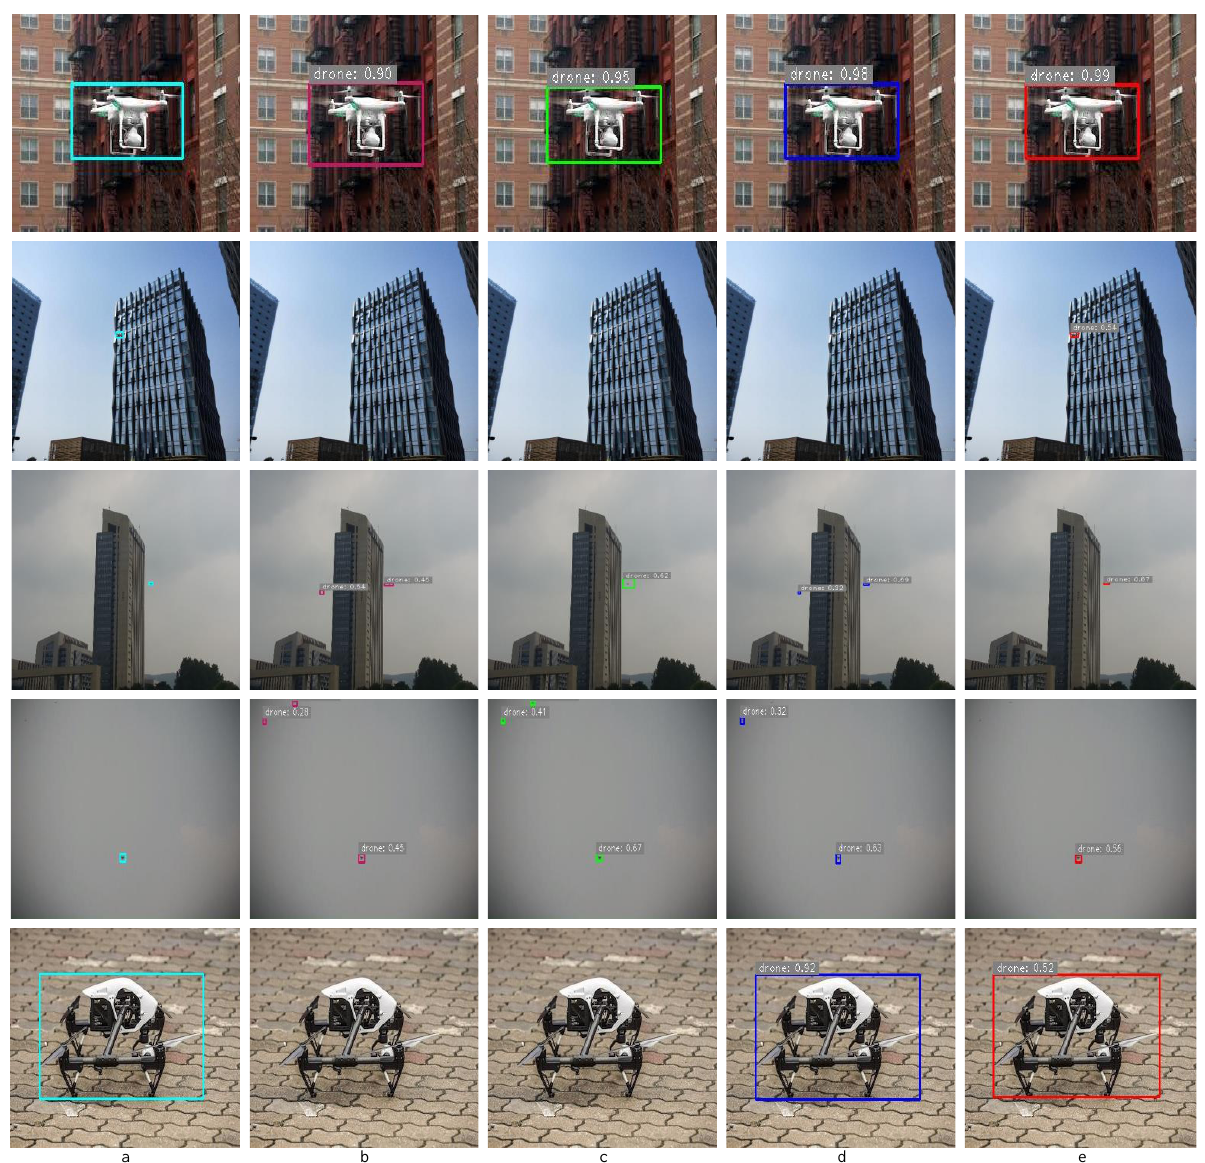
Figure 10. Comparison of the different detectors: ( a ) Ground truth; ( b ) detection result of CenterNet with ResNet-18 as its backbone; ( c ) detection result of CenterNet with ResNet-34 as its backbone; ( d ) detection result of MFACN with ResNet-18 as its backbone; and ( e ) detection result of the proposed method, CFACN, with ResNet-18 as its